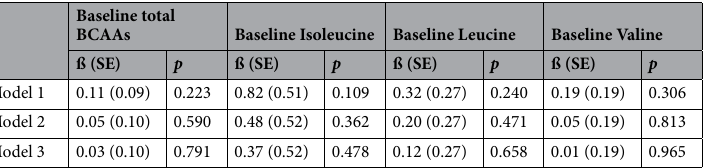
Table 2. Associations of liver fat content and total BCAAs, Isoleucine, Leucine, or Valine levels before exercise intervention among individuals with nonalcoholic fatty liver disease. ß (SE) represents changes of the outcomes per change in the circulating metabolite levels during the exercise intervention. Model 1: adjusted for age, sex, total energy intake, protein intake, and intervention groups; Model 2: adjusted for covariates in Model 1 + HOMA-IR; Model 3: adjusted for covariates in Model 2 + BMI. Abbreviations: HOMA-IR homeostatic model assessment of insulin resistance; BMI body mass index.